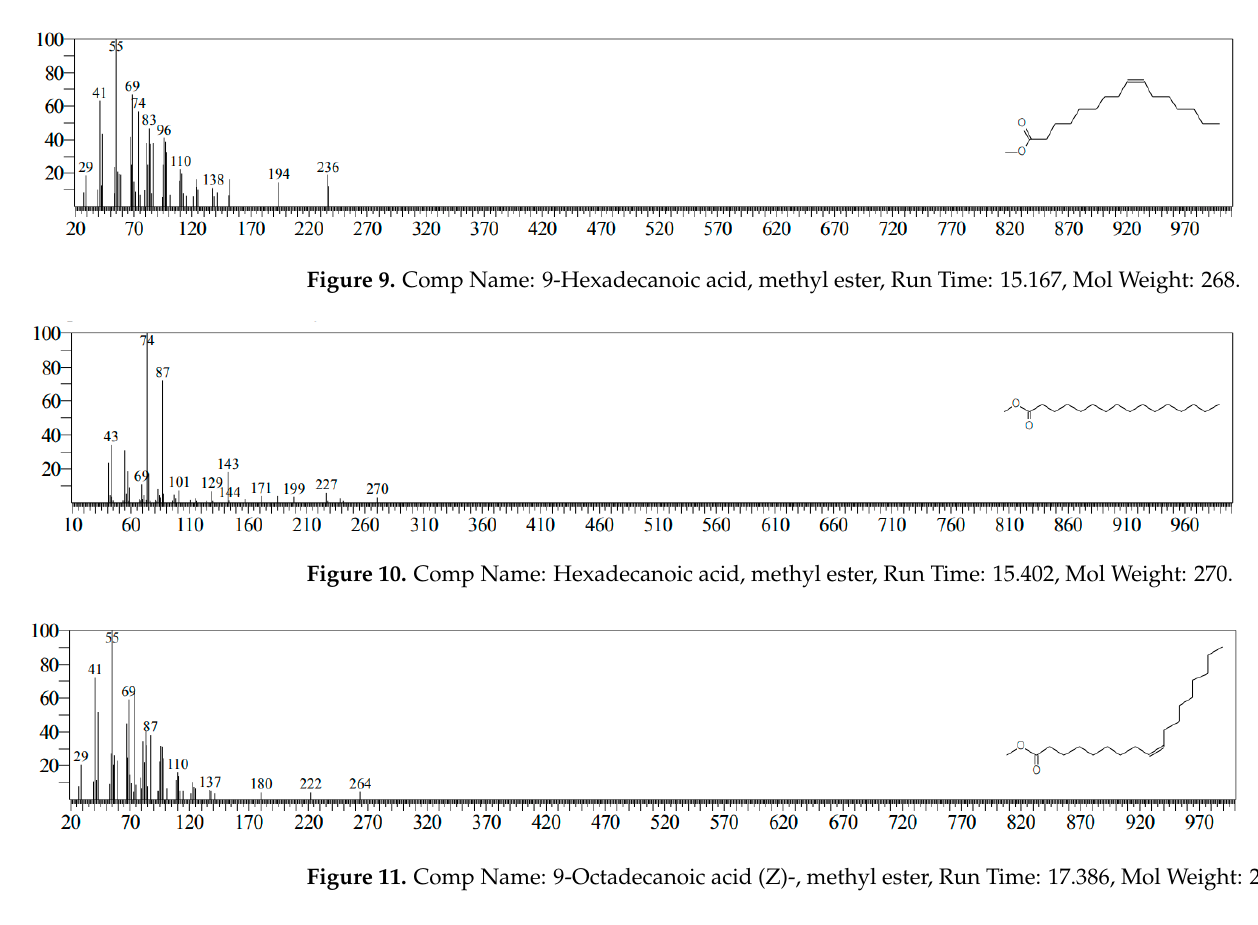
Figure 8. Comp Name: n-hexane, Run Time: 2.480, Mol Weight: 86.